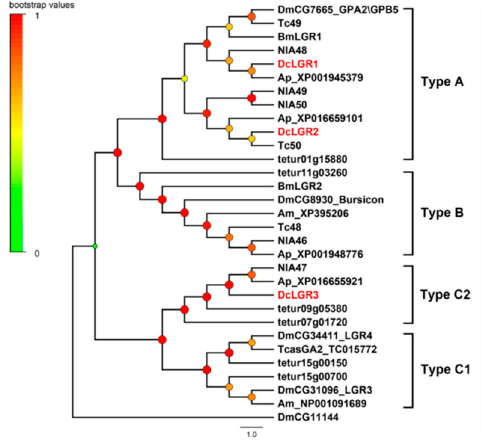
Figure 4. Phylogenetic tree of leucine-rich repeat-containing GPCRs (LGRs). The neighbor-joining trees were constructed using MEGA 6 software with 1000-fold bootstrap repetitions. The LGRs of D. citri are shown in red text. Dc, D. citri ; Dm, D. melanogaster ; Nl, N. lugens ; Bm, B. mori ; Tc, T. castaneum . Ap, Acyrthosiphon pisum ; Am, A. mellifera ; tetur, Tetranychus urticae .